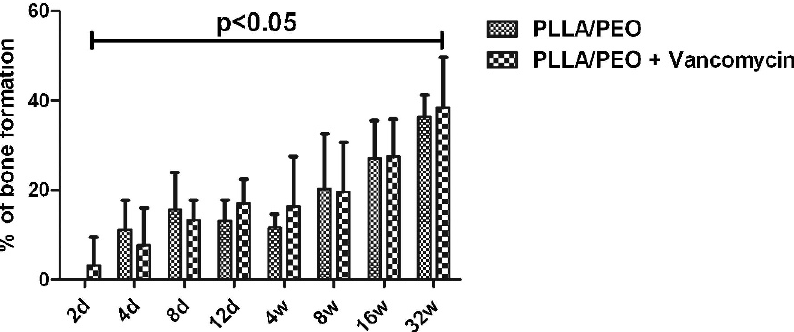
Figure 6 - Percentage of bone formation during the different experimental periods for the vancomycin-loaded PLLA/PEO microspheres and vancomycin-unloaded PLLA/PEO. The periods that showed no values are equivalent to